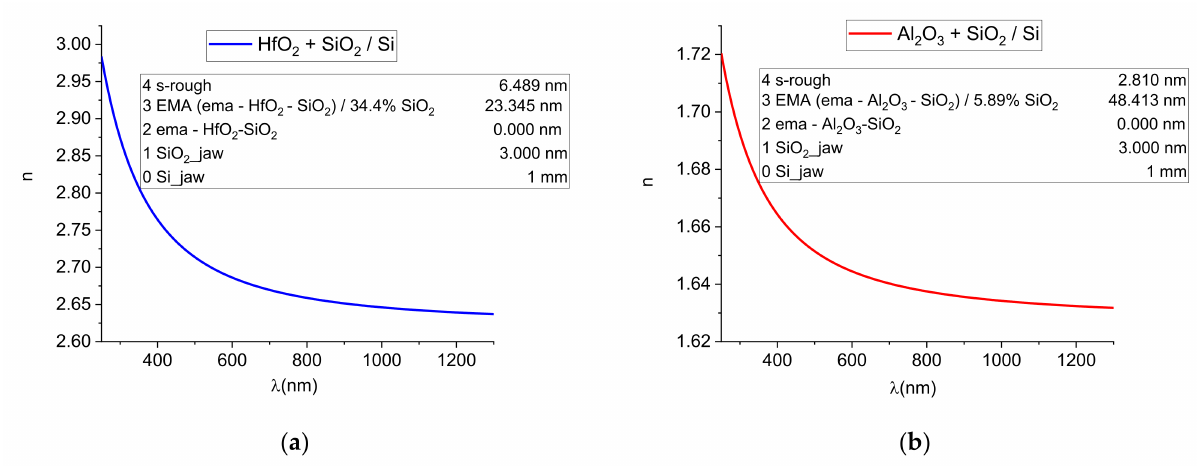
Figure 5. The dispersion of the refractive index calculated from SE by using EMA in Bruggeman’s model for ( a ) hafnium silicate and ( b ) aluminium silicate layers.